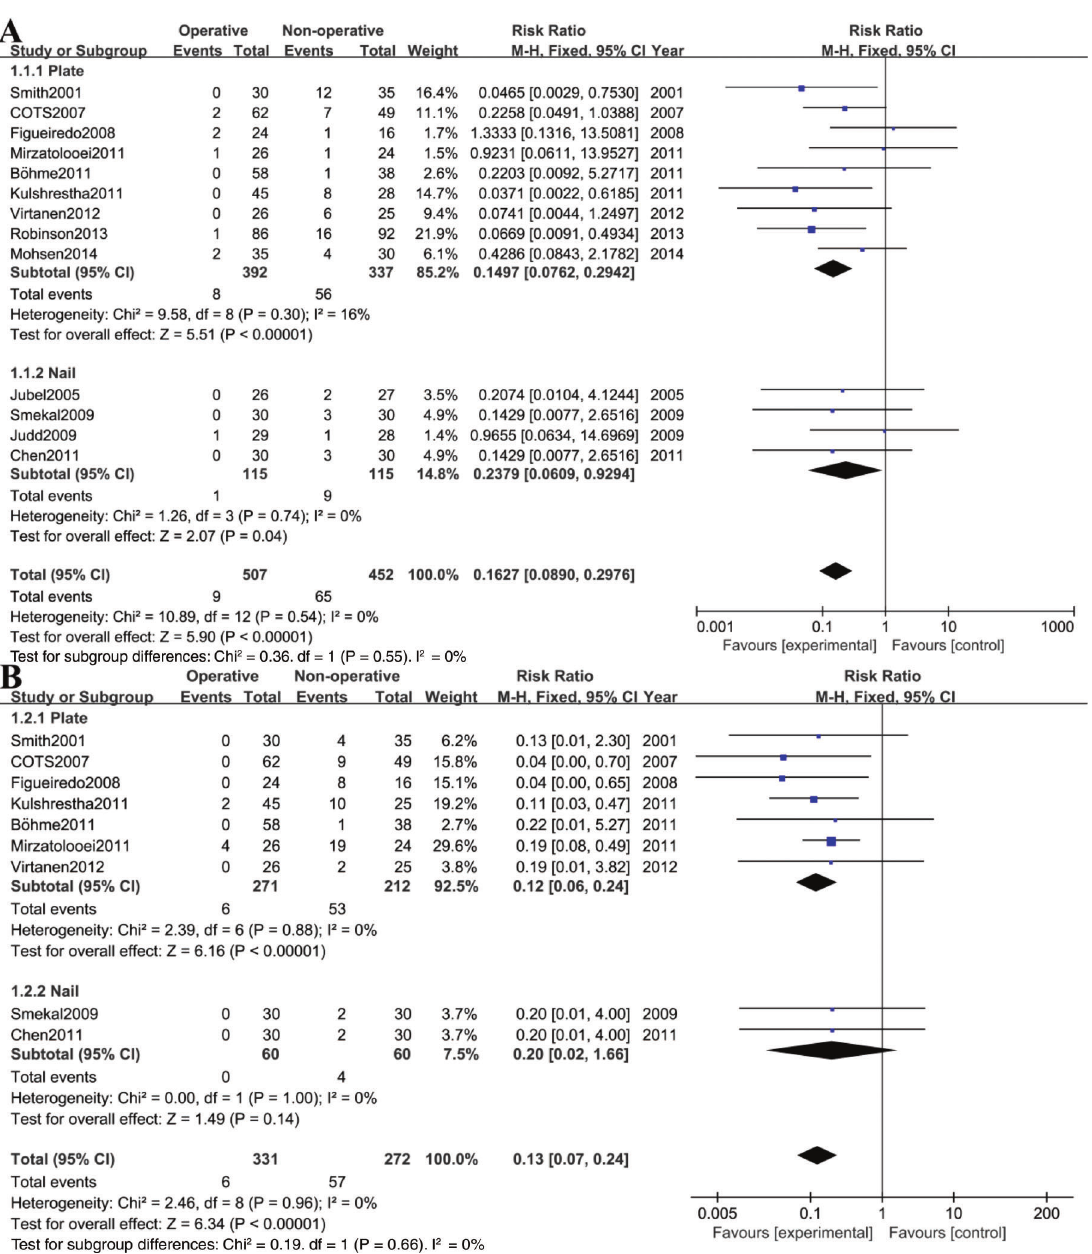
Figure 2 - Forest plot showing comparison of nonunion rate (A) and symptomatic malunion rate (B) between operative (experimental) and nonoperative (control)